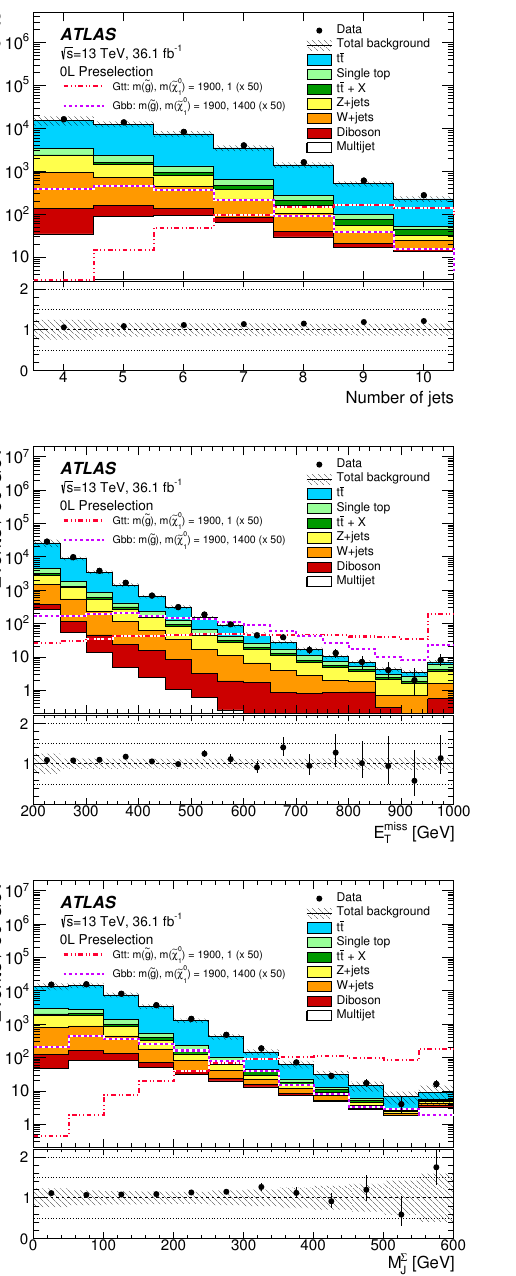
Figure 3. Distributions of (top-left) the number of selected jets ( N selected b -tagged jets, (centre-left) E miss